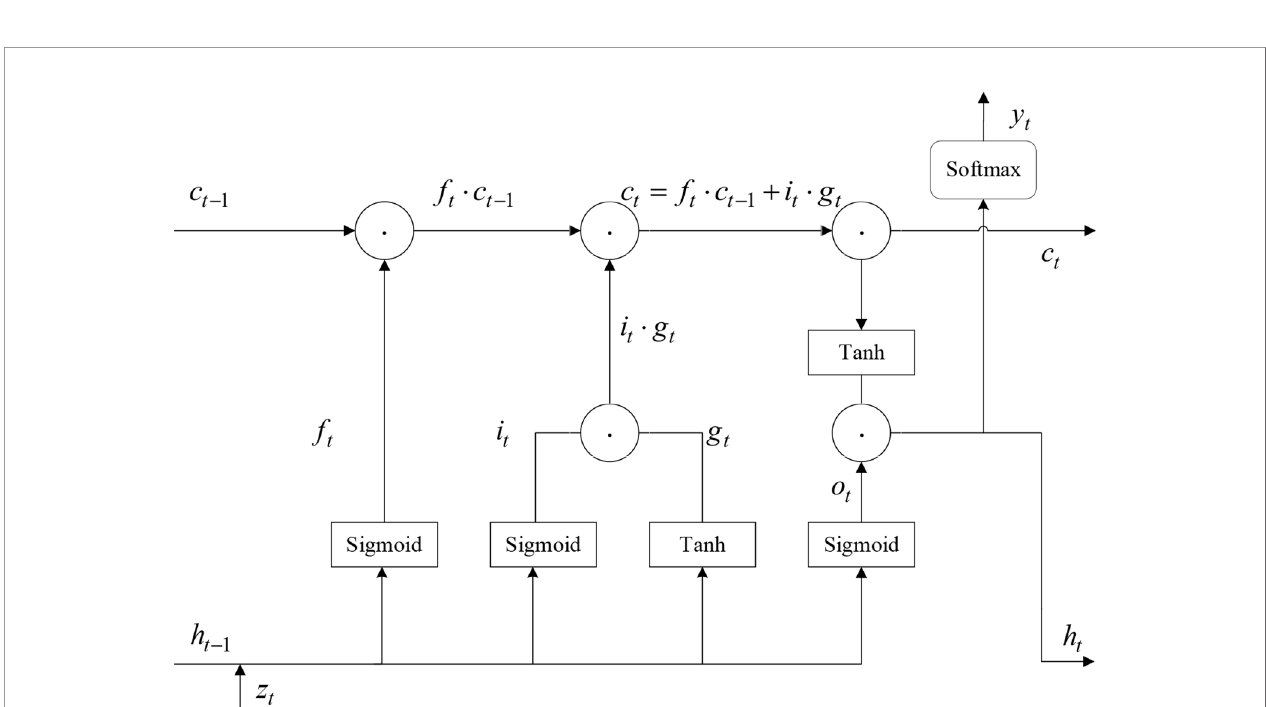
FIGURE 3 | LSTM module